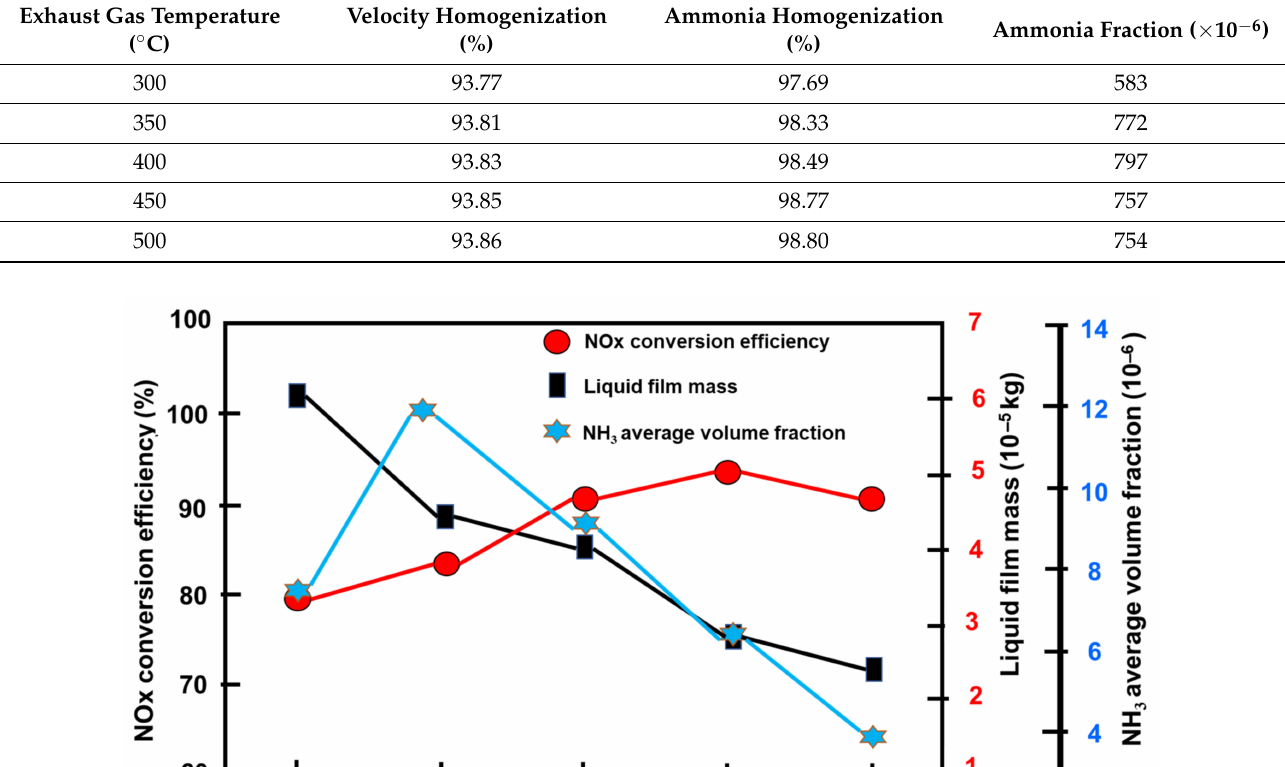
Table 3. Values of parameters at different exhaust temperatures, adapted from Wang et al. [74].